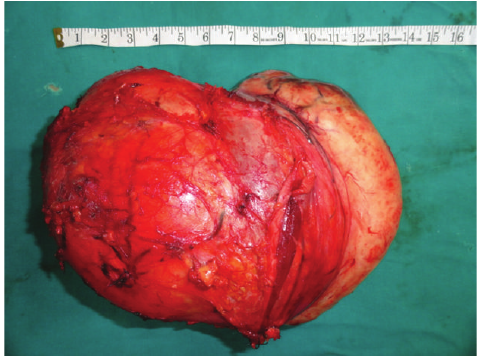
Figure 6: Showing excised specimen.